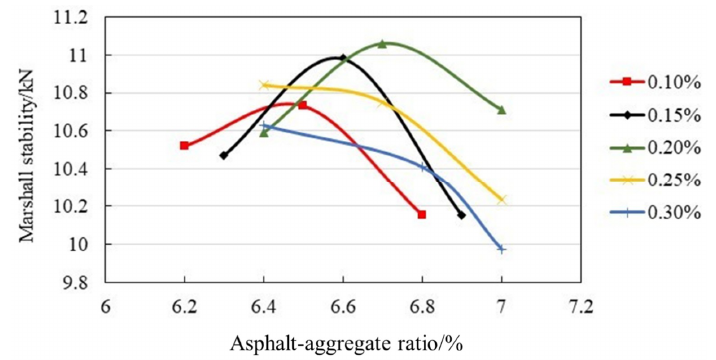
ff erent fiber content and asphalt-aggregate ratio. Figure 5. Stability under different fiber content and asphalt-aggregate ratio. Figure 5. Stability under di